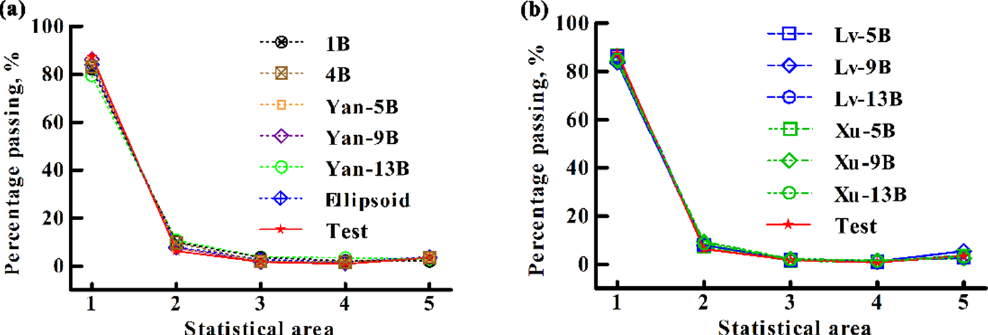
Figure 15. Comparisons of the simulated percentages passing with the test ones in different statis-